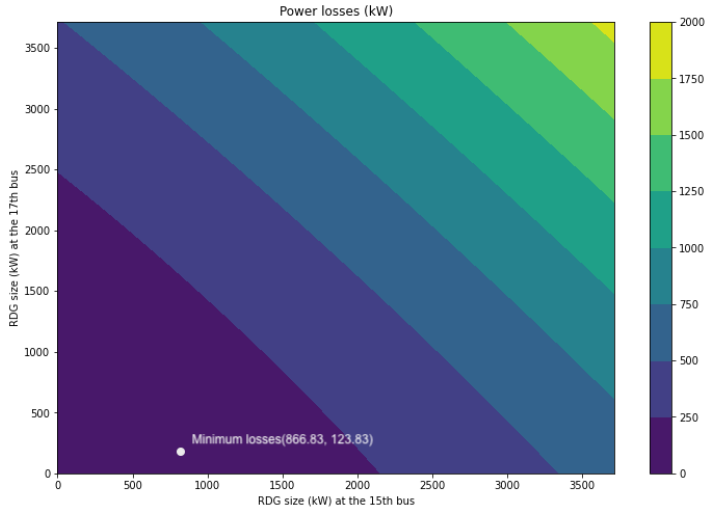
Figure 9. Variation of power losses with two RDGs for the IEEE 33-bus test distribution system. Table 9. Comparison results of optimal locations and sizes for installing two RDGs of IEEE 33-bus distribution test system ( ↑ : improvement of voltage stability; ↓ degradation of voltage stability; red.: power loss